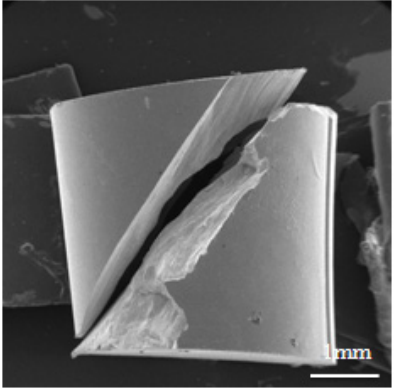
Figure 5. The SEM fractograph of Zr-based metallic glass deformed at a strain rate of 2.2 × 10 3 s − 1